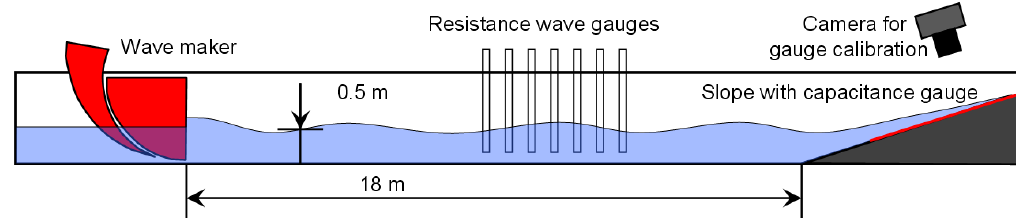
Fig. 2. Experimental setup.